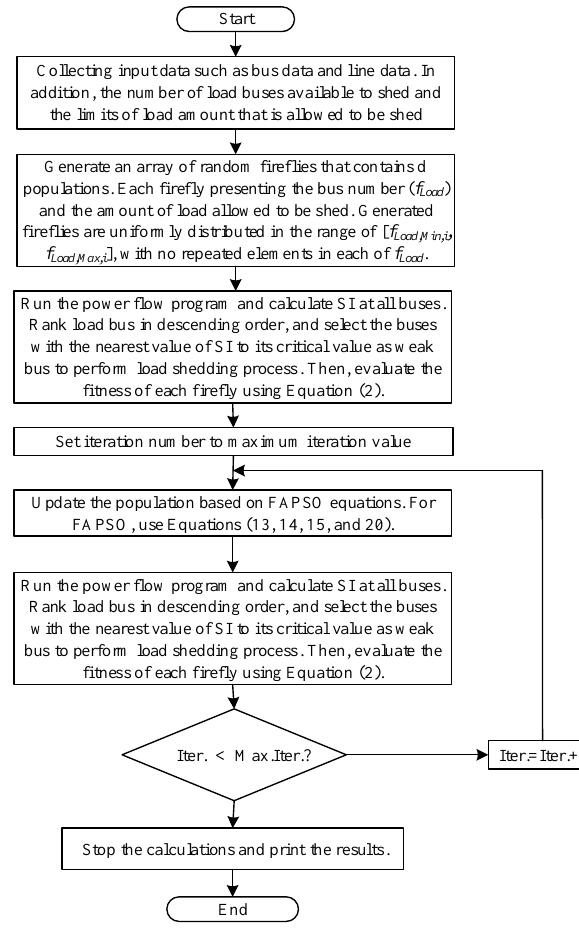
Figure 3 . Flowchart of proposed planning load shedding scheme. Figure 3. Flowchart of proposed planning load shedding